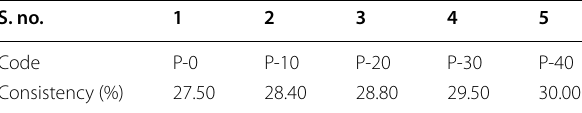
Table 7 Normal consistency of cement and blended cement